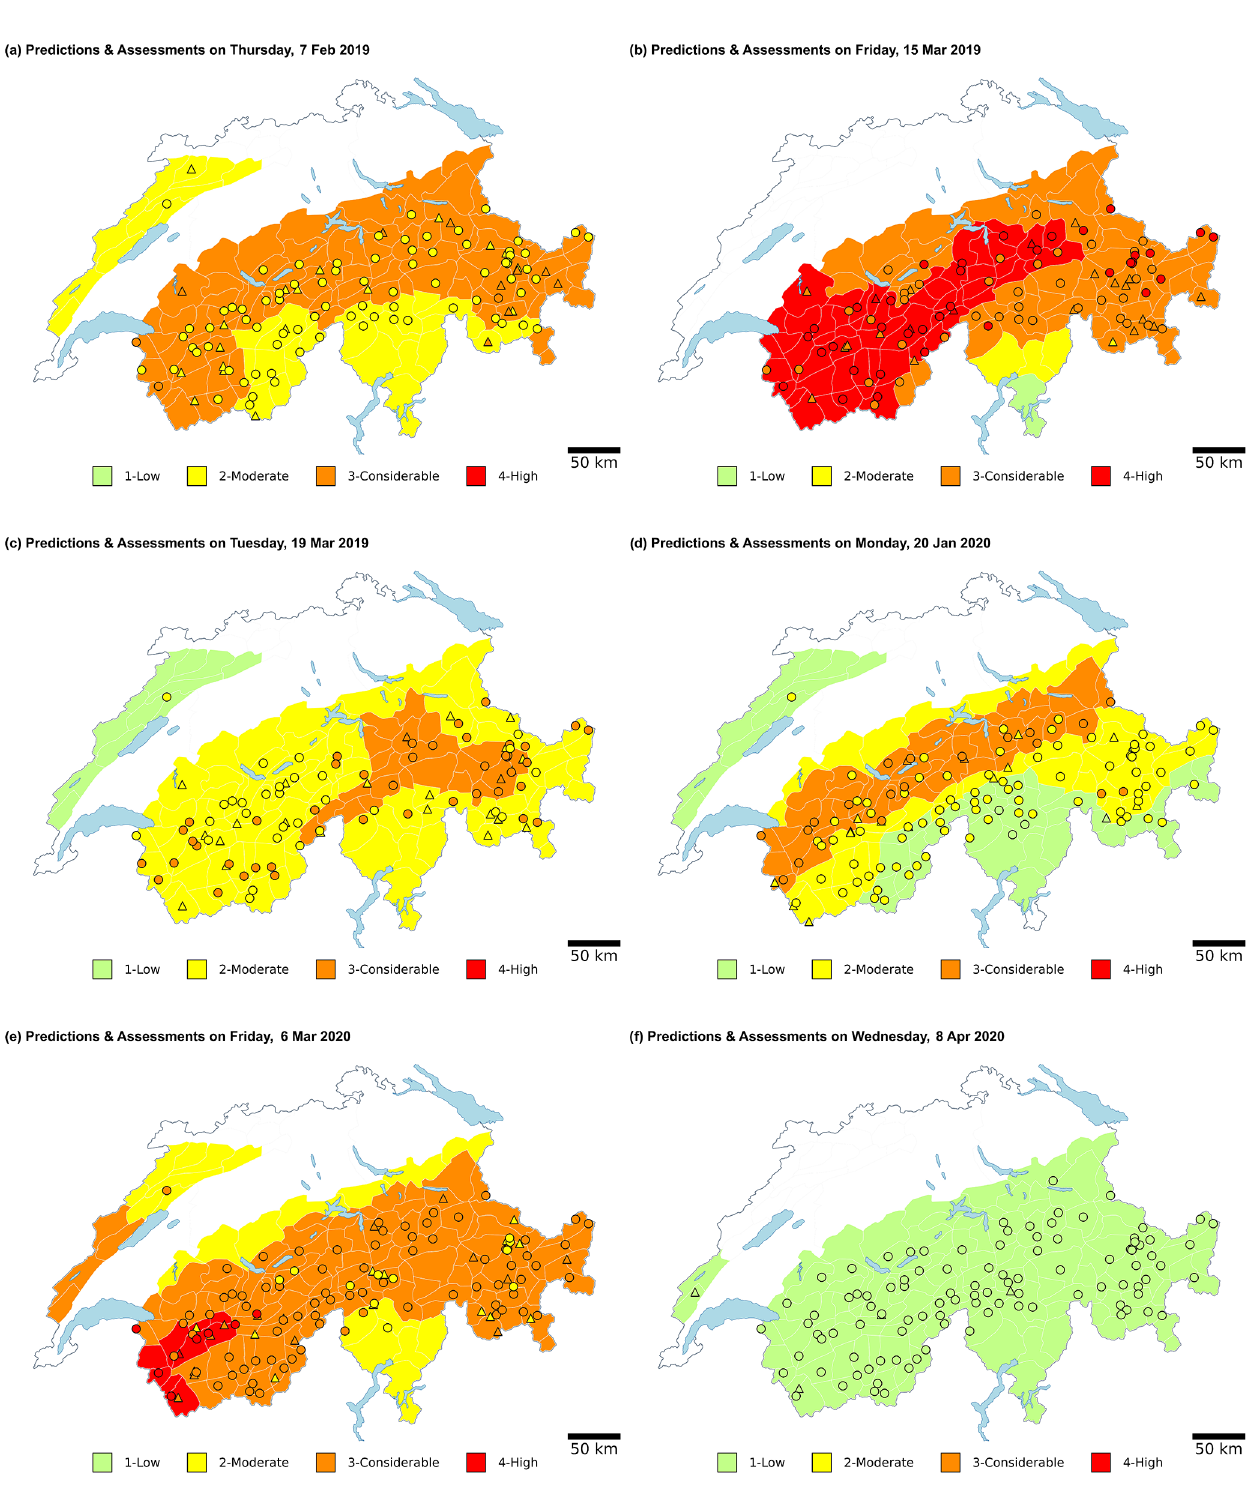
Figure D1. Maps of Switzerland showing the danger level of the public forecast for each region; the danger level predictions by the RF 1 model at each IMIS station (coloured circles); and the local nowcast assessments (coloured triangles) reported by observers on six selected dates – (a) 7 February 2019, (b) 15 March 2019, (c) 19 March 2019, (d) 20 January 2020, (e) 6 March 2020, and (f) 8 April 2020. The colours represent the danger